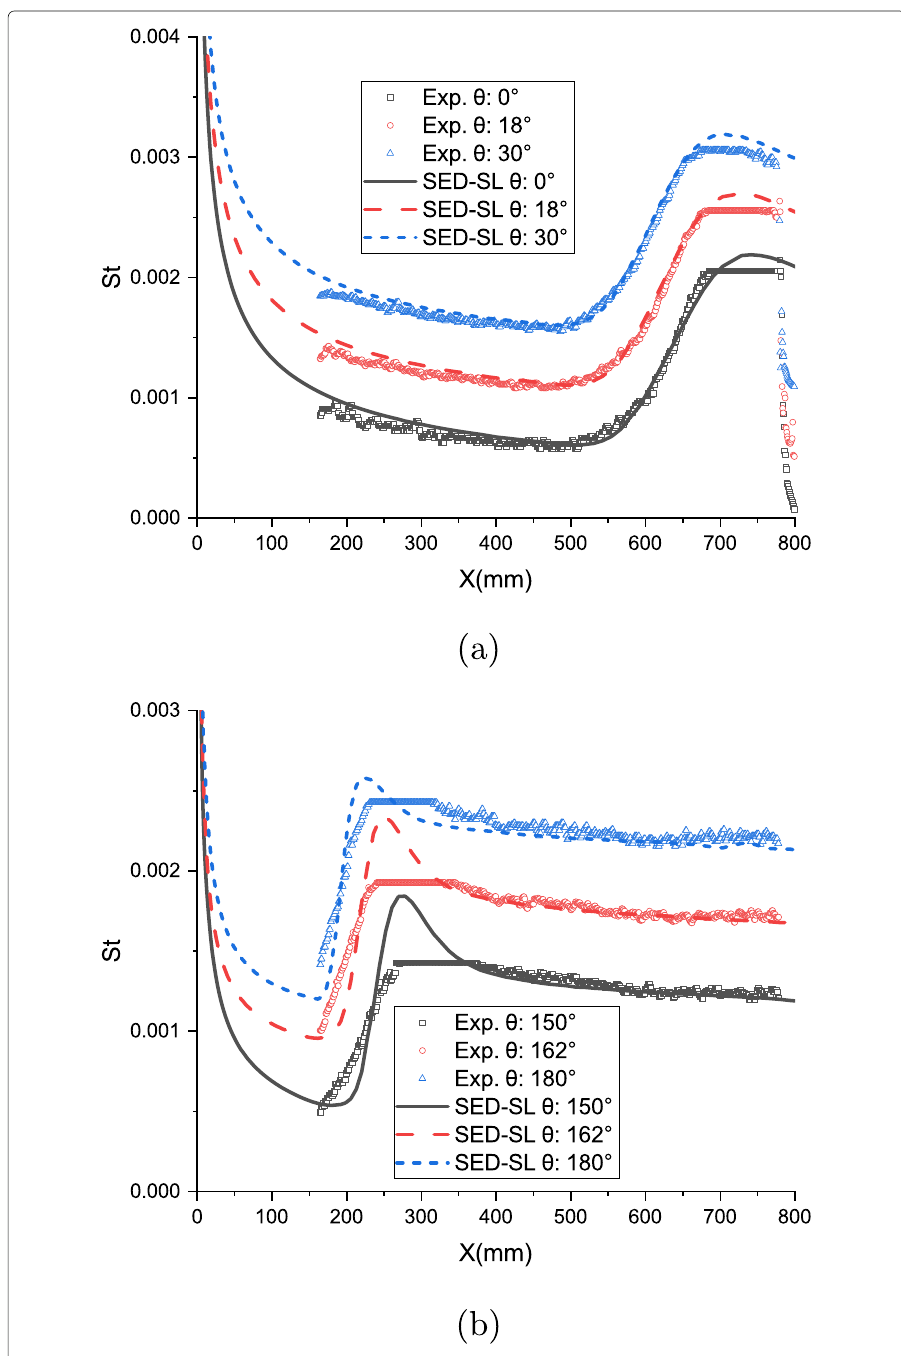
Fig. 10 Comparisons between the rescaled surface temperature increment distributions measured in experiment and the St distributions computed by the SED-SL model for the CARDC-2 case. a The windward surface, b the leeward surface. The data are vertically translated to be clearly displayed